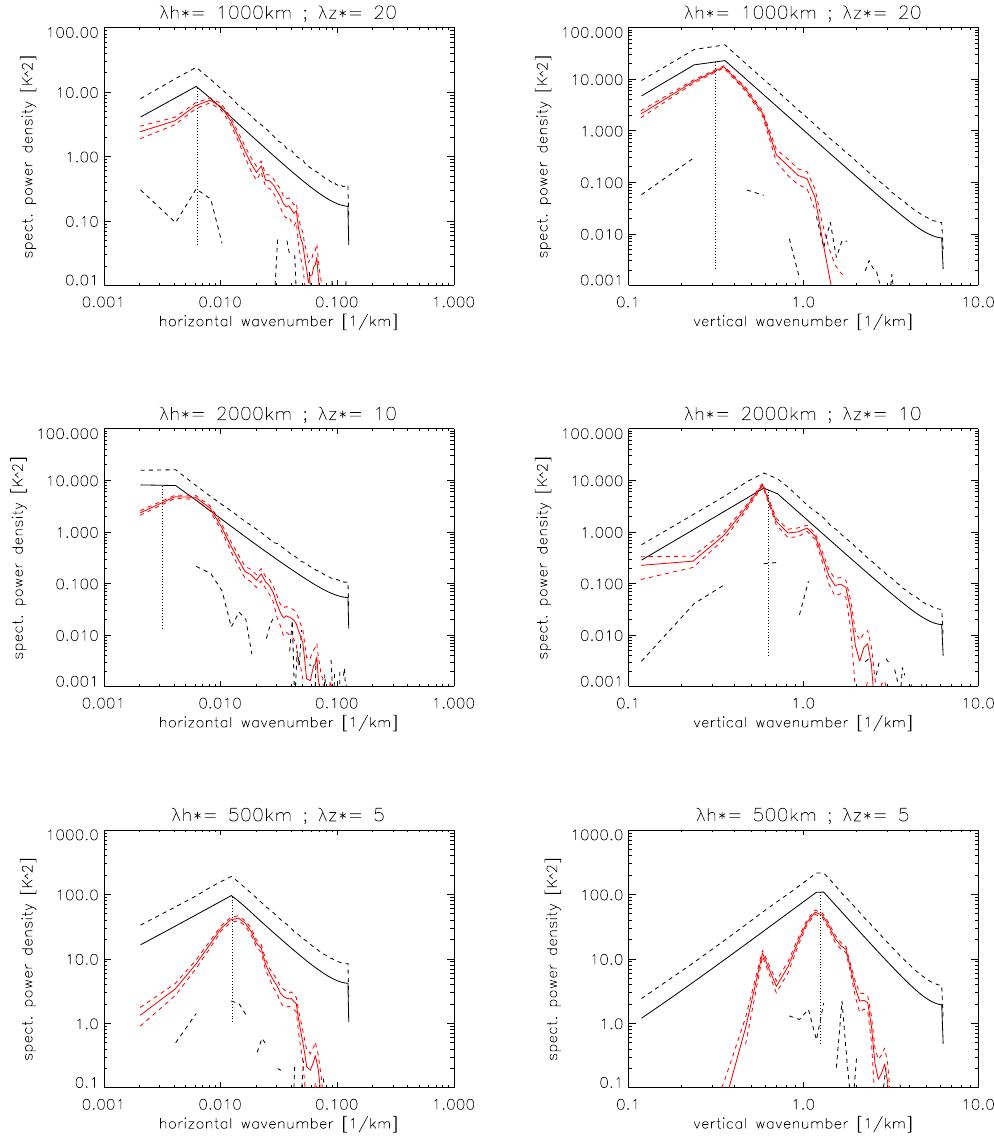
Fig. A1. Comparison of (red) S3D and (black) 1-D Fourier transform spectra for (left column) horizontal and (right column) vertical coordi- nates. The solid lines give the average spectrum, dashed lines for the FT show the standard deviation of all 1-D FT spectra in one data set. We have repeated the whole experiment for 100 independent random phase configurations: the according standard deviation is denoted for the S3D method by dashed